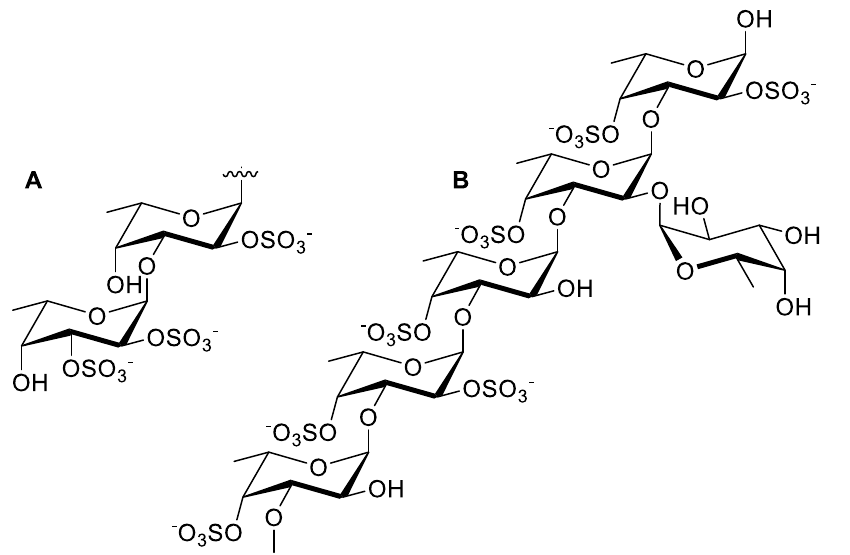
Figure 3. Chemical structure of the fucoidan from ( A ) Fucus vesiculosus and Ascophyllum nodosum and ( B ) Laminaria saccharina [70].